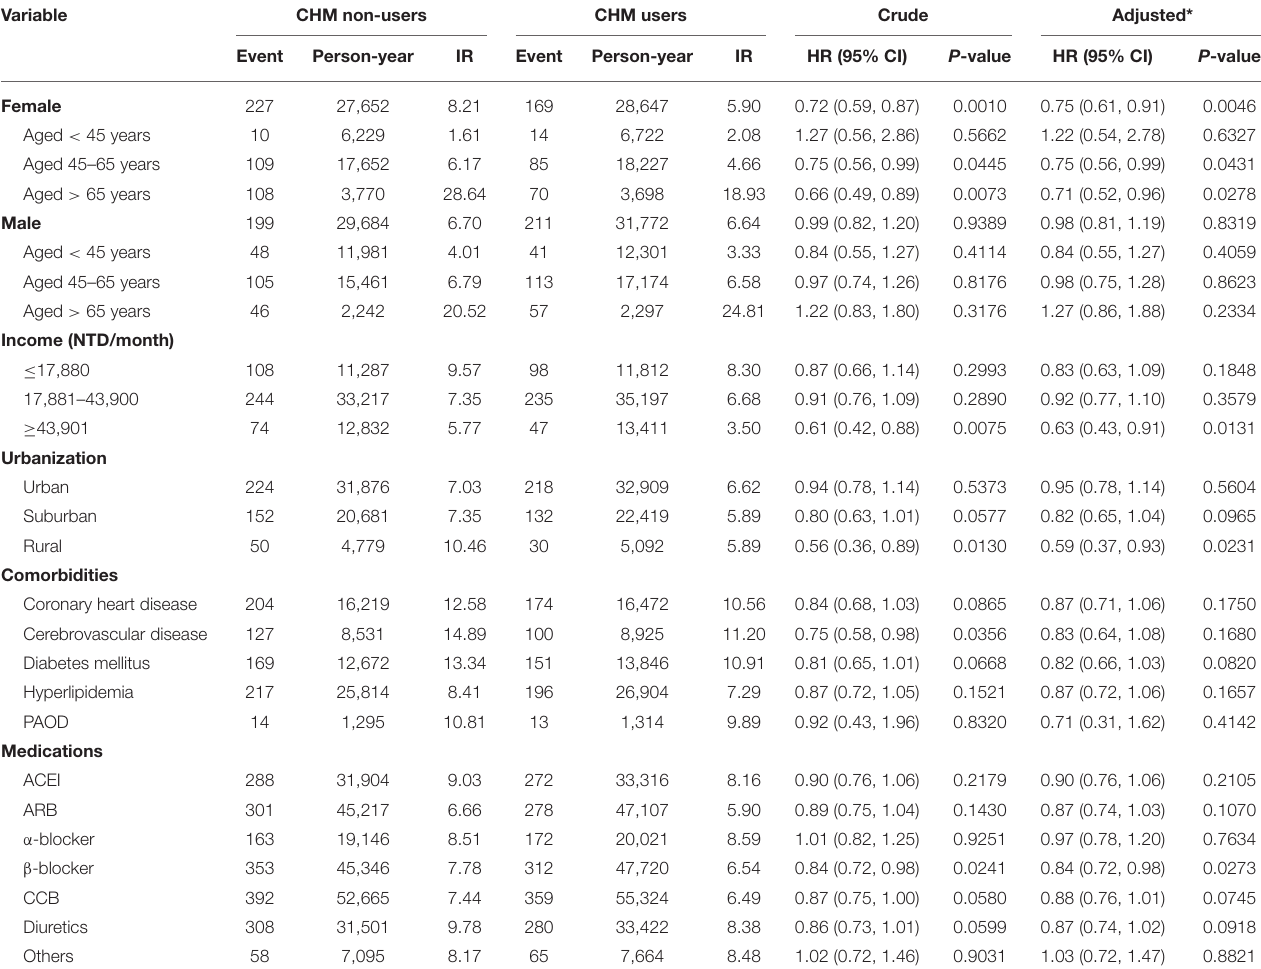
TABLE 4 | IRs and crude and adjusted HRs with 95% CIs of heart failure between hypertensive patients with and without CHM treatment, stratified by baseline characteristics, comorbidities, and medications.